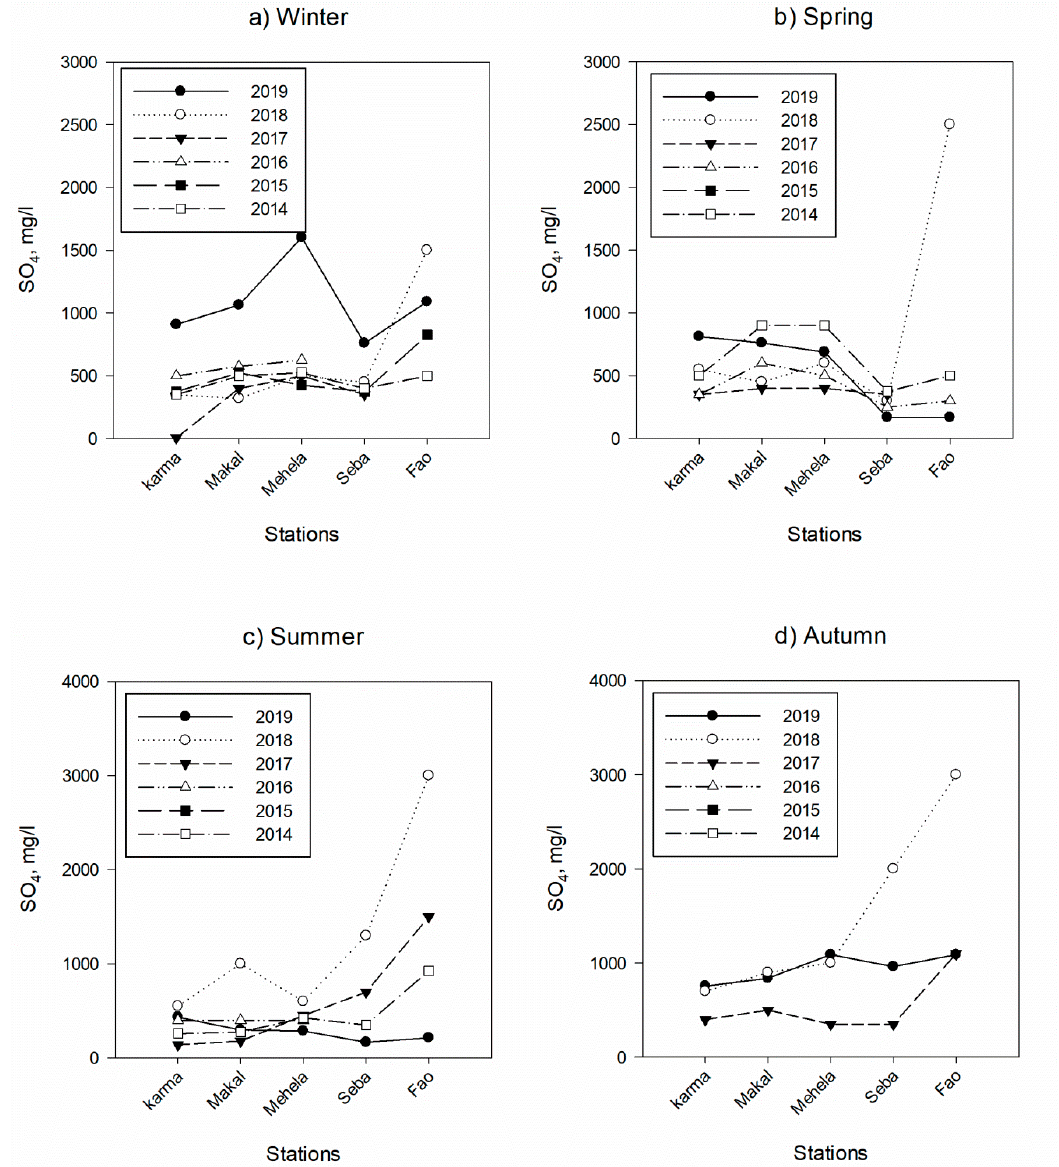
Figure 9. Comparison of SO 4 concentrations of the selected stations for four seasons during the period of 2014 to 2019.